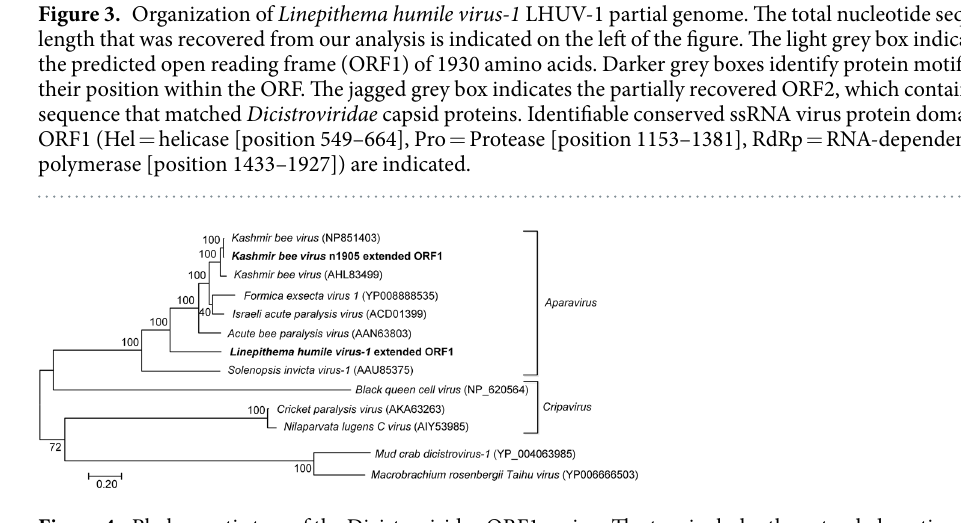
Figure 4. Phylogenetic tree of the Dicistroviridae ORF1 region. The tree includes the extended contig n1905 (proposed KBV strain) and LHUV-1 using a Le & Gascuel (LG) 54 model with 500 bootstrap replicates. The ORF1 sequences included in the analysis comprise the complete Helicase, Protease and Ribosomal dependent RNA polymerase (RdRp) domains of these viruses and intergenic regions. Macrobrachium rosenbergii Taihu virus and Mud crab discistrovirus-1 (two unclassified Dicistroviridae that had ~50% identity to our contigs in blastp results) were included to root the tree. Our sequences are shown in bold text. GenBank accession numbers are shown in